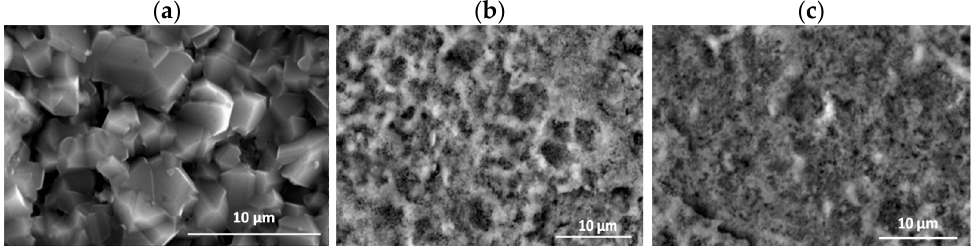
Figure 13. Fragment of the surface in fields ( a ) A, ( b ) B and ( c ) C marked in Figure 12.